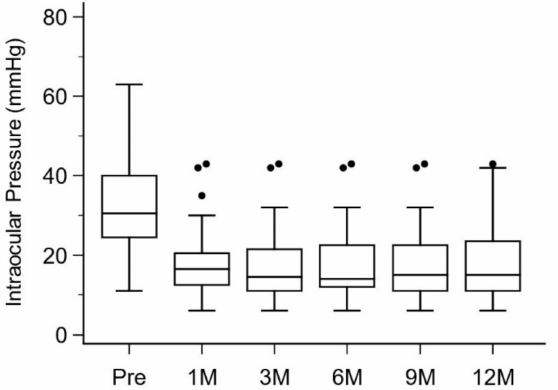
Figure 3. Box and whisker plots of intraocular pressure at different time points. Pre,